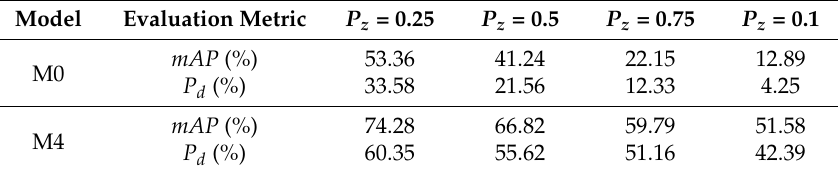
Table 2. M4 anti-occlusion interference verification.